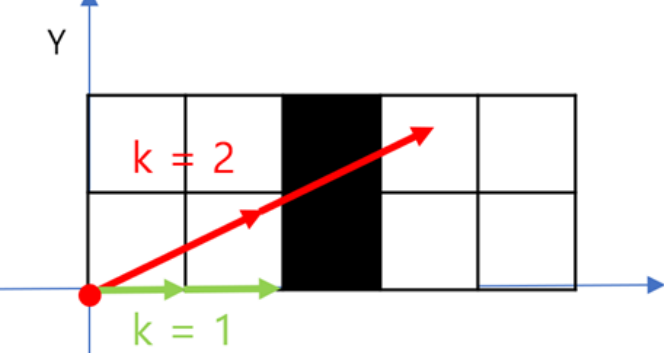
Figure 8. Comparison between k = 1 and k =